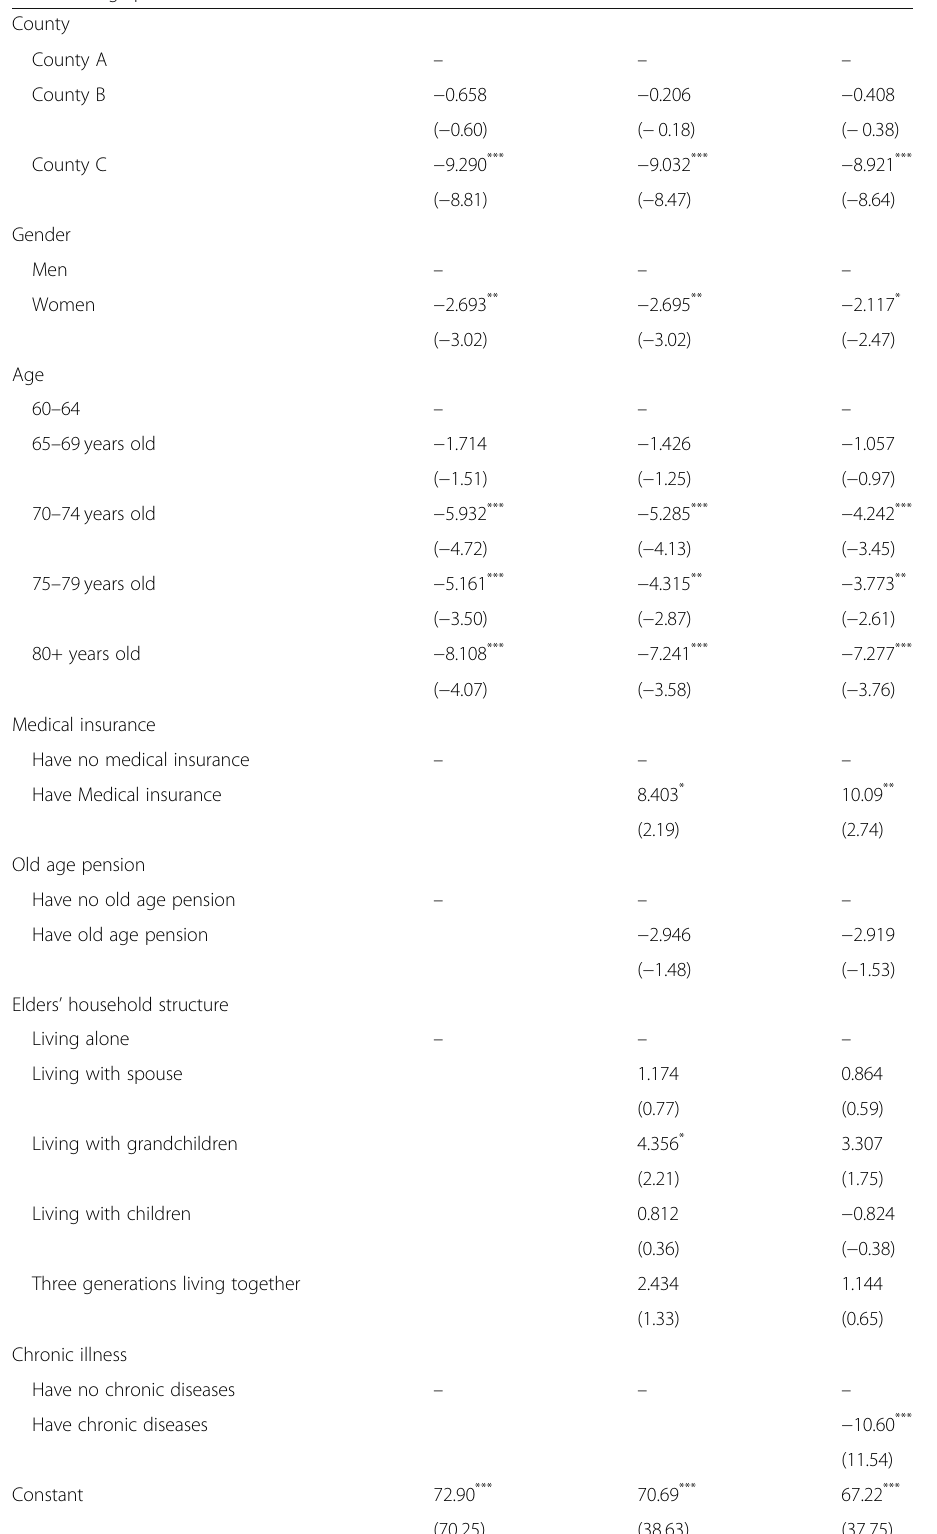
Table 10 Determinants of rural elders ’ self-rated health